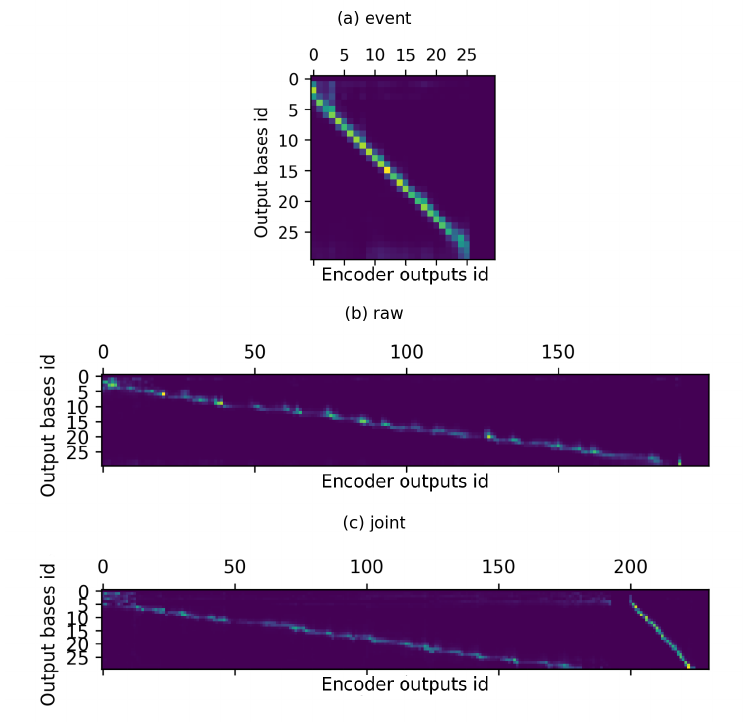
Figure 8. Plots of attention weights applied to different parts of input data depending on predicted output base id: ( a ) for event processing model, ( b ) raw processing model, ( c ) joint raw and event processing